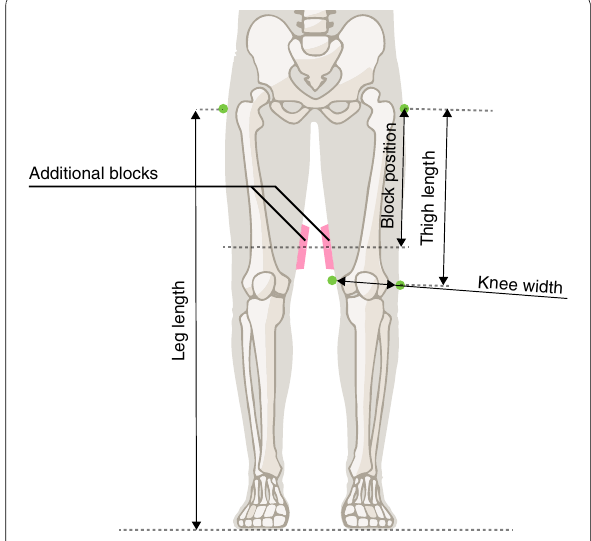
Fig. 1 Definition of variables of subject measurements and additional block position. These green circles represent makers for a motion capture system. The picture represents a subject standing upright. These additional blocks are on medial surface of the